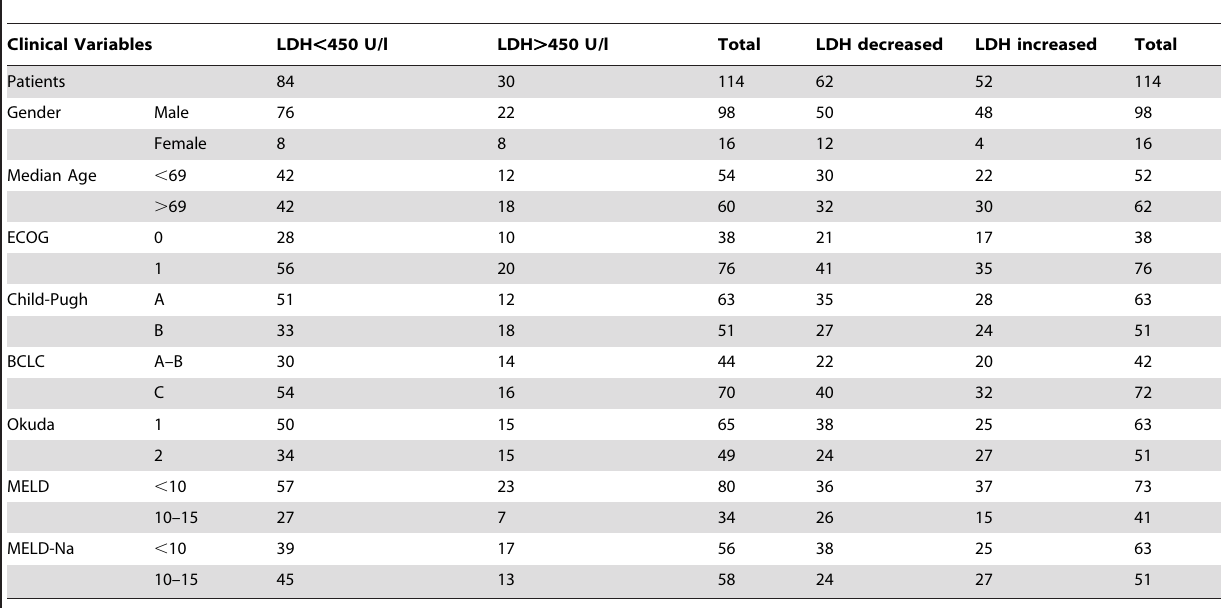
Table 1. Clinical variables examined resulted balanced between the group of patients with high lactic dehydrogenase (LDH) serum levels (LDH . 450 U/l) and those with a low value (LDH , 450 U/l) and in those with a decreased or increased LDH serum level after transarterial-chemoembolization (TACE) treatment.